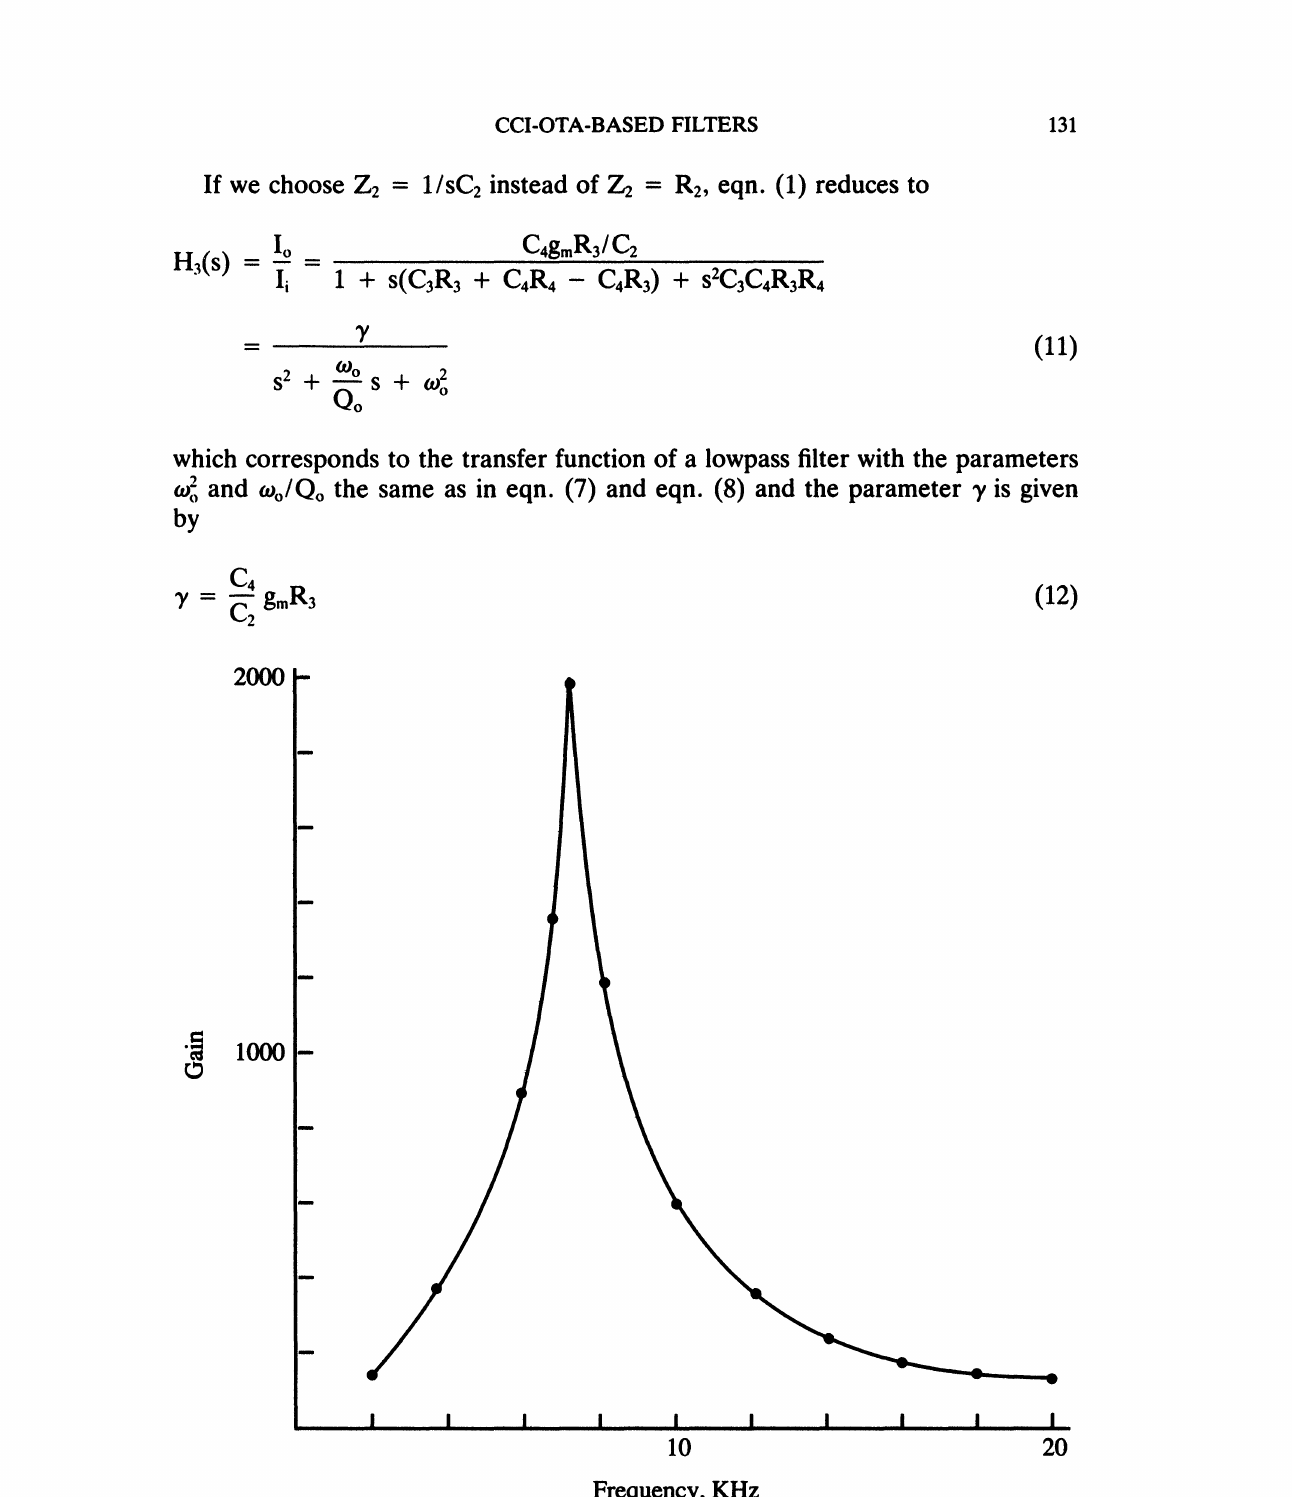
FIGURE 2 Characteristics of the BPF of Eqn. (2) " Calculated (eqn. (2)), o: